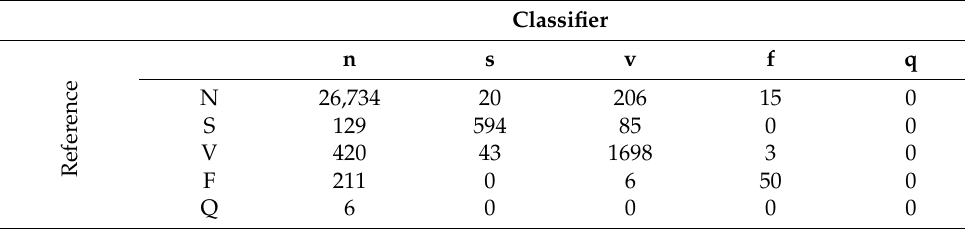
Table 11. Confusion matrix